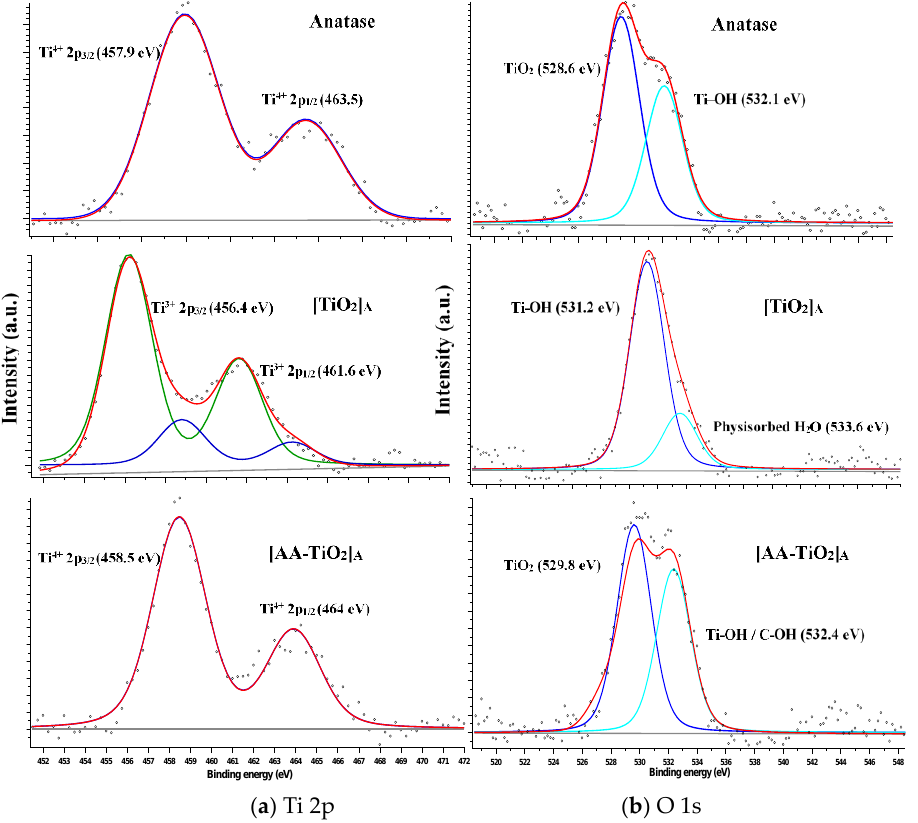
Figure 4. X-ray photoelectron spectroscopy (XPS) spectra of commercial Anatase (top), pure [TiO 2 ] A (in the middle) and modified [AA-TiO 2 ] A (bottom) containing 2.5 wt % of AA for ( a ) Ti 2p and ( b ) for O 1s.